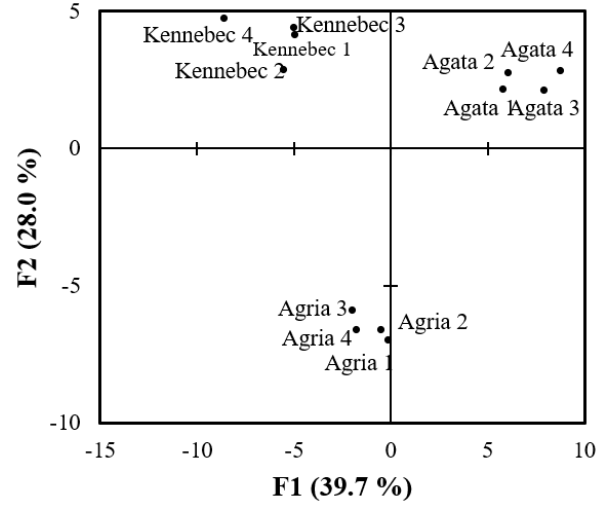
Figure 3. Principal component analysis (PCA) using the volume of 78 differentially abundant ( p < 0.05) spots between Agata, Kennebec and Agria (replicates 1–4) potato cultivars at the endodor- mancy stage.